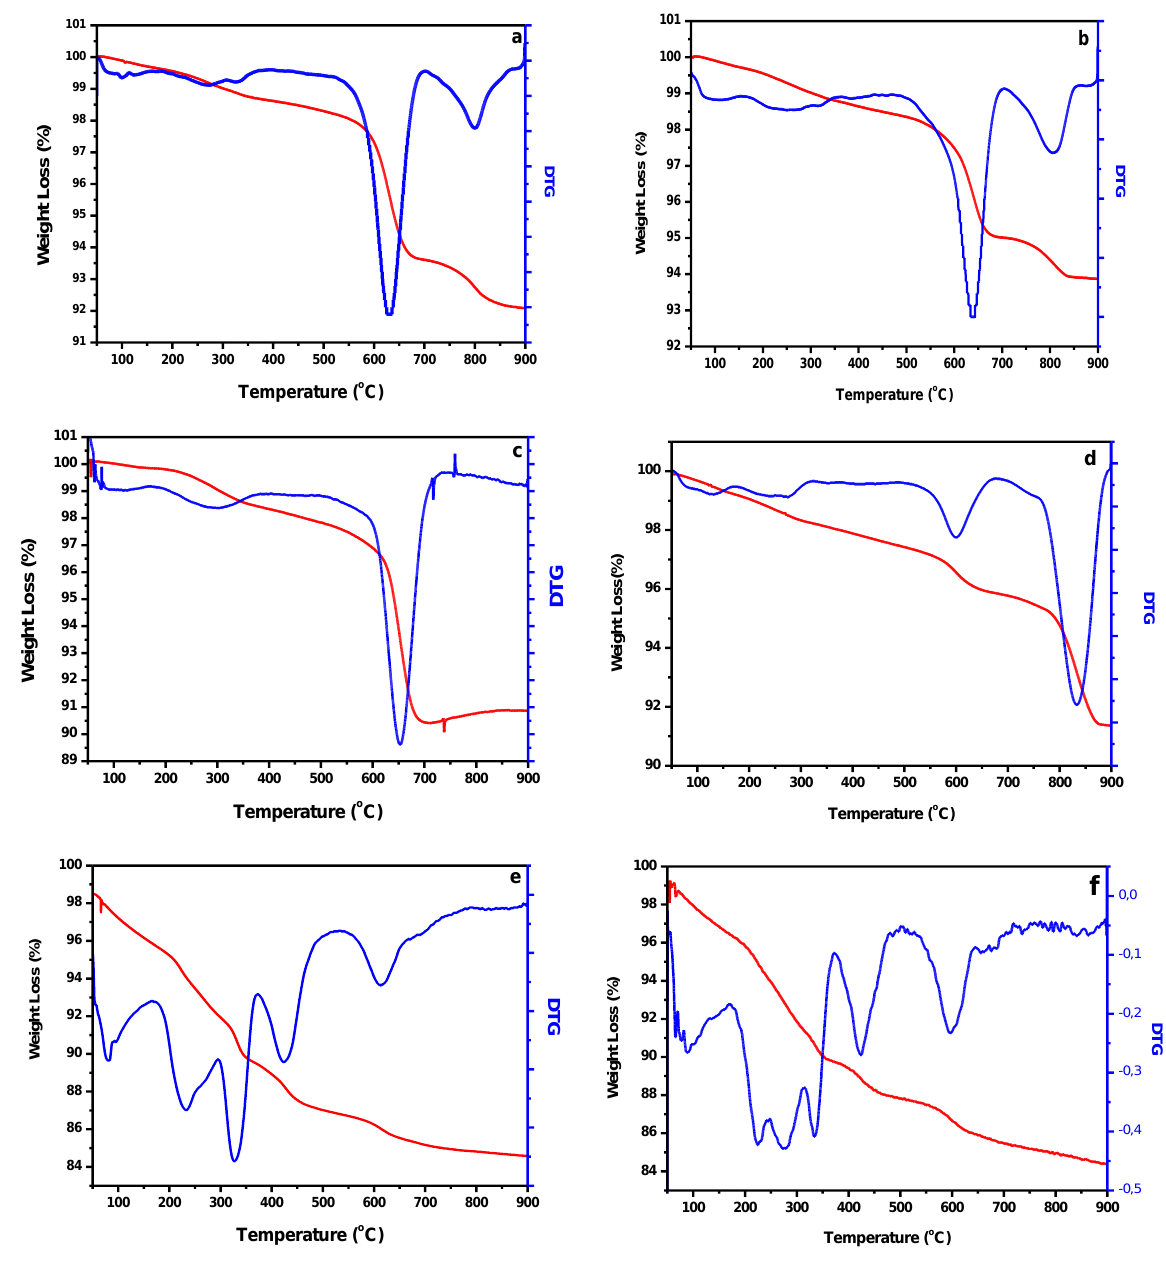
Figure 4. TGA analysis of the La composites with different ratios. ( a ) LaCoO 3 (1:1), ( b ) LaCoO 3 (2:3), ( c ) LaNiO 3 (1:1), ( d )LaNiO 3 with (2:3), ( e ) LaFeO 3 (1:1), and ( f ) LaFeO 3 (2:3). X-ray photoelectron spectroscopy (XPS) measurements on the nanocomposites (i.e.,